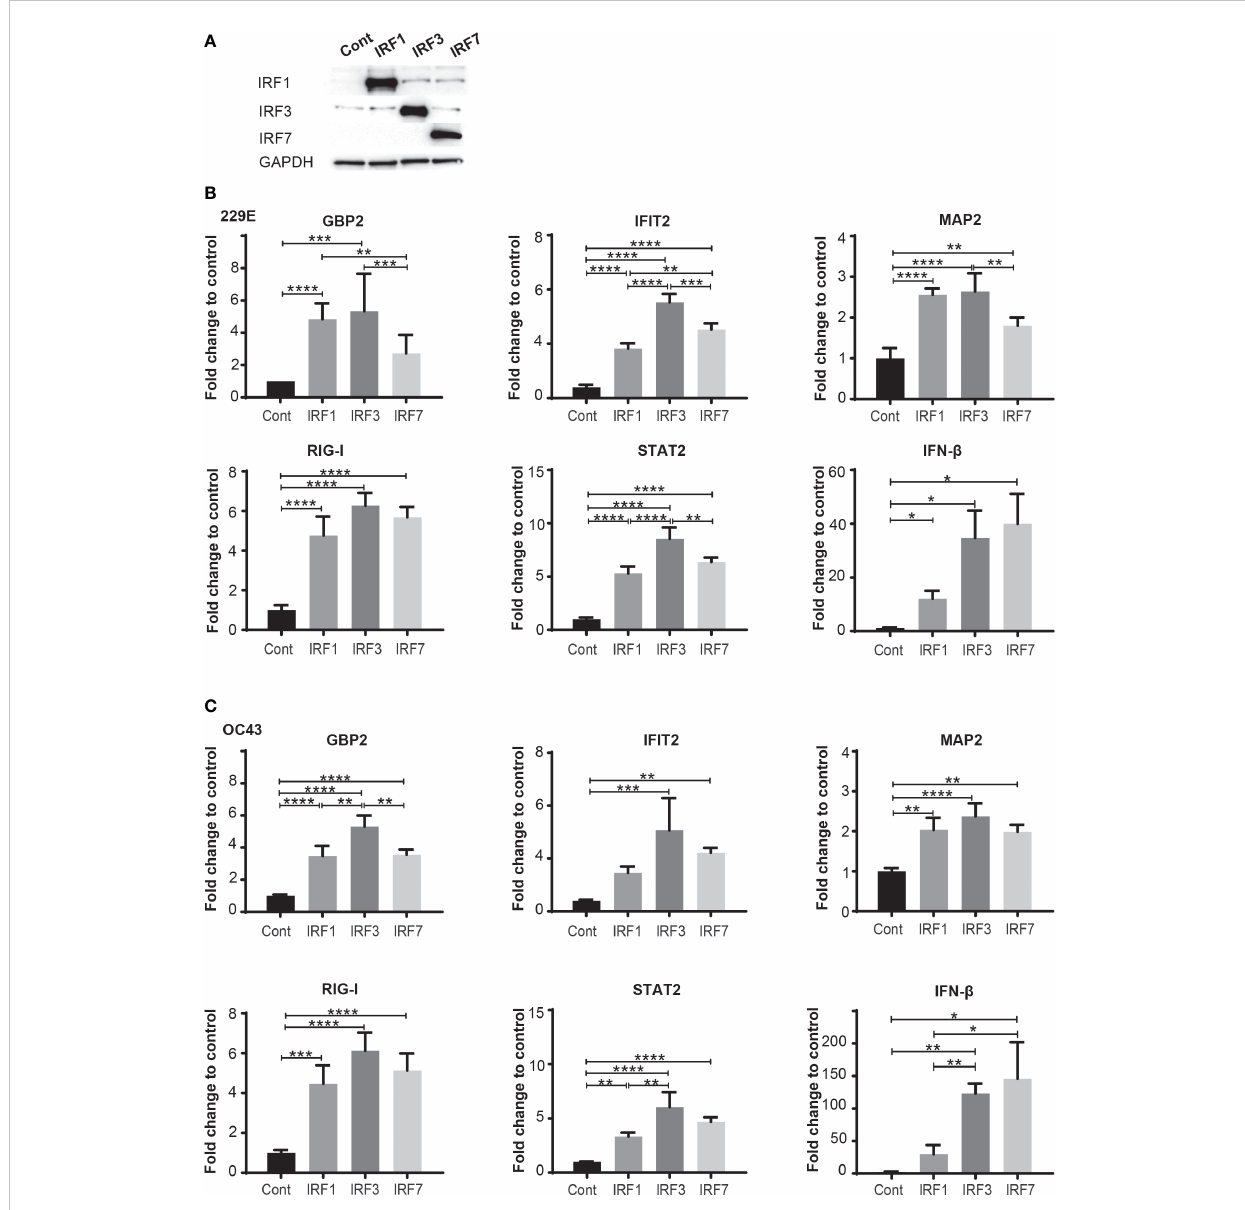
FIGURE 6 IRF3 effectively activates transcription of antiviral genes during human coronavirus infection. H1299 cells were transfected with control pcDNA3 plasmid (Cont) or the plasmid containing IRF1, IRF3 or IRF7 and then infected with or without 229E or OC43 at MOI of 0.01. (A) The expression of IRF1, IRF3 and IRF7 was con fi rmed by western blot analysis. At 24 hours after infection, the expression of GBP2, IFI2, MAP2, RIG-I, STAT2 and IFN- b in the cells infected with 229E (B) or OC43 (C) was determined by RT-qPCR (n=4). *p<0.05, **p<0.01, ***p<0.001, ****p<0.0001, Two-way